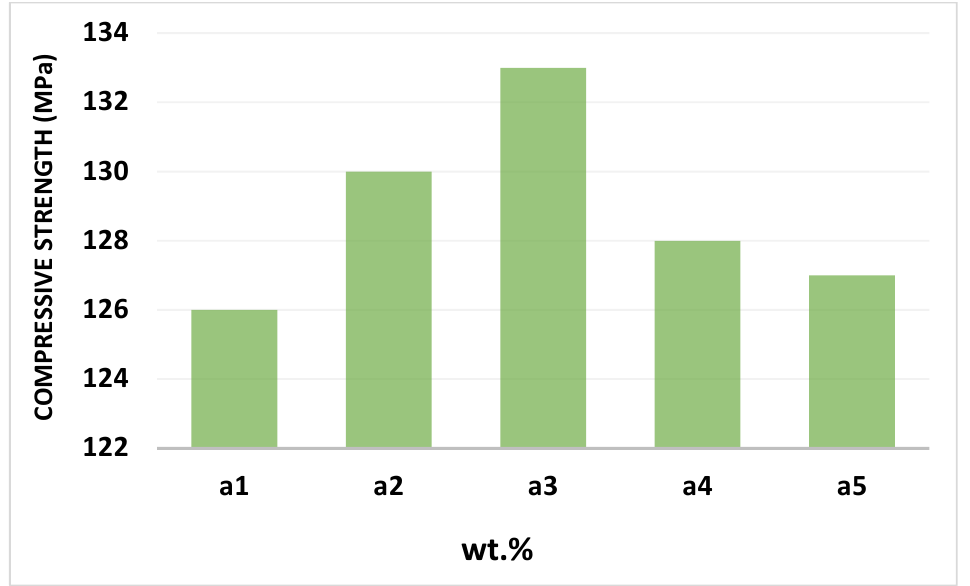
Figure 12. Compressive strength composite specimens with different weight percentages of rein- forcement.